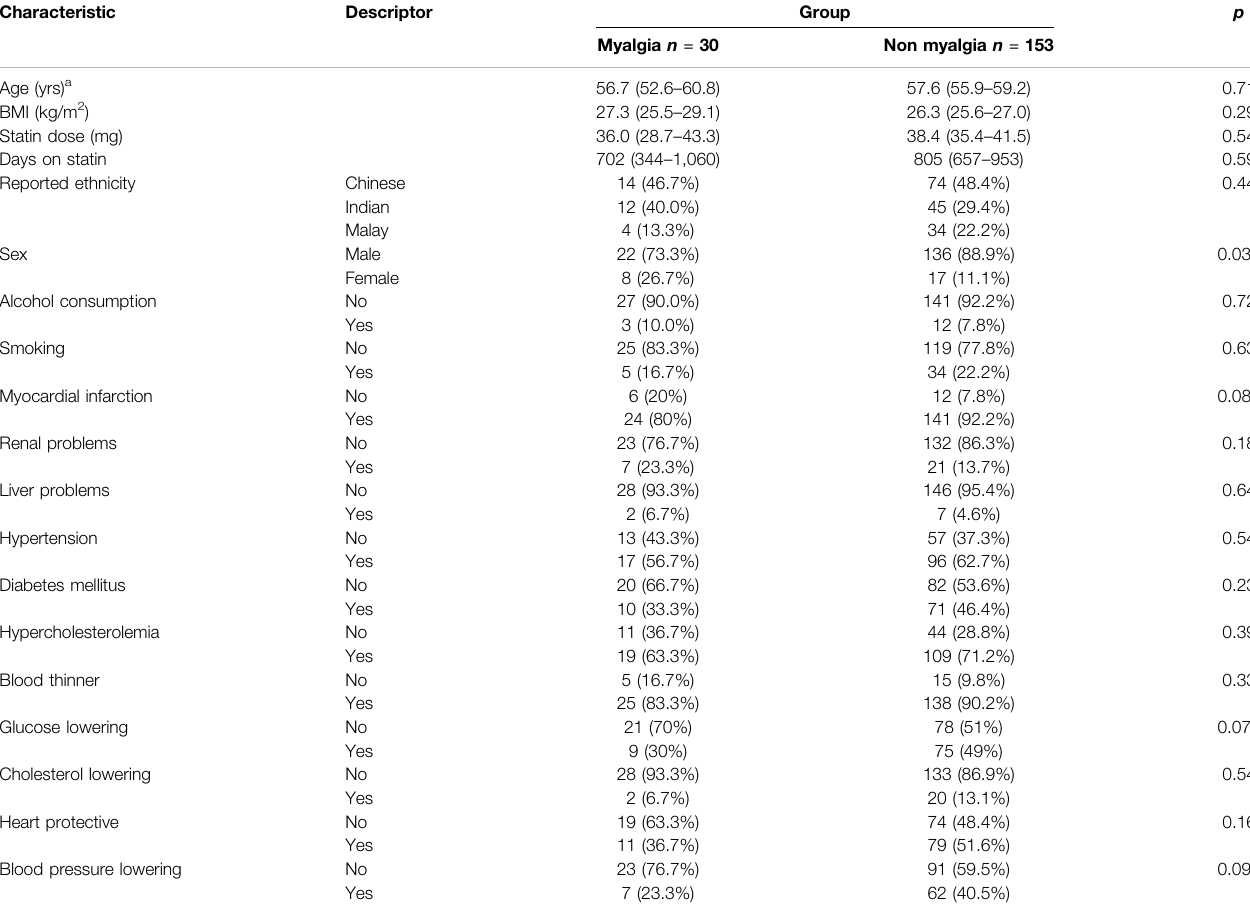
TABLE 1 | Clinical/demographic characteristics of myalgia (cases) and non-myalgia (controls) subjects.